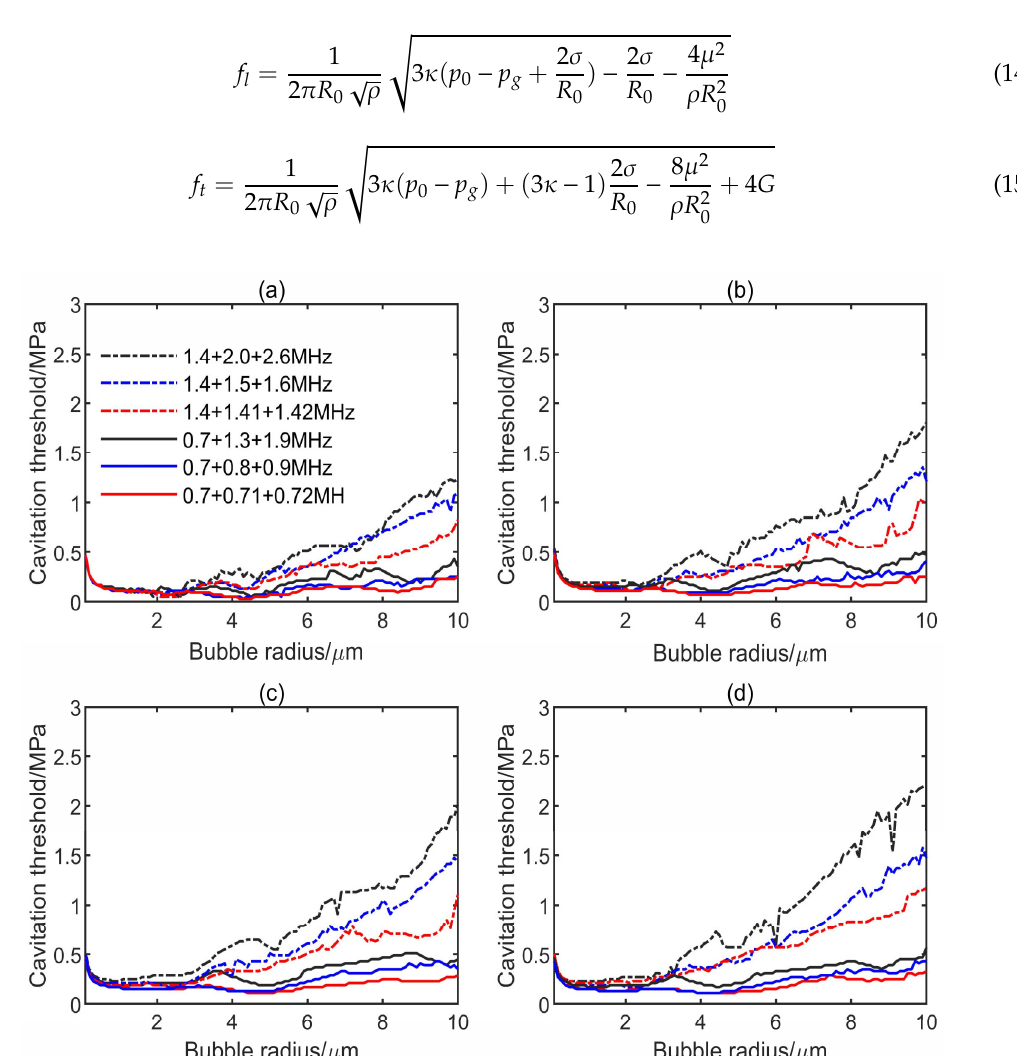
Figure 1. Transient cavitation threshold corresponding to different triple-frequency combinations in different media: ( a ) water; ( b ) blood; ( c ) brain; ( d ) liver.